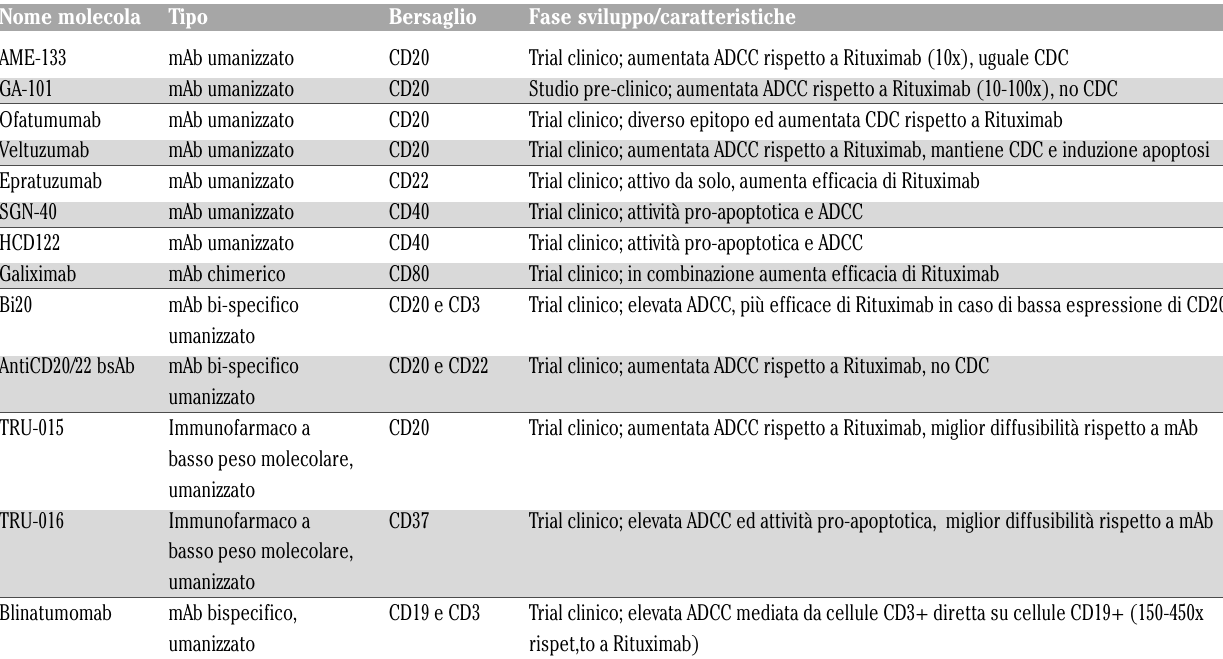
Tabella 2. Nuovi farmaci immunologici in corso di valutazione per uso clinico nei linfomi non-Hodgkin a cellule